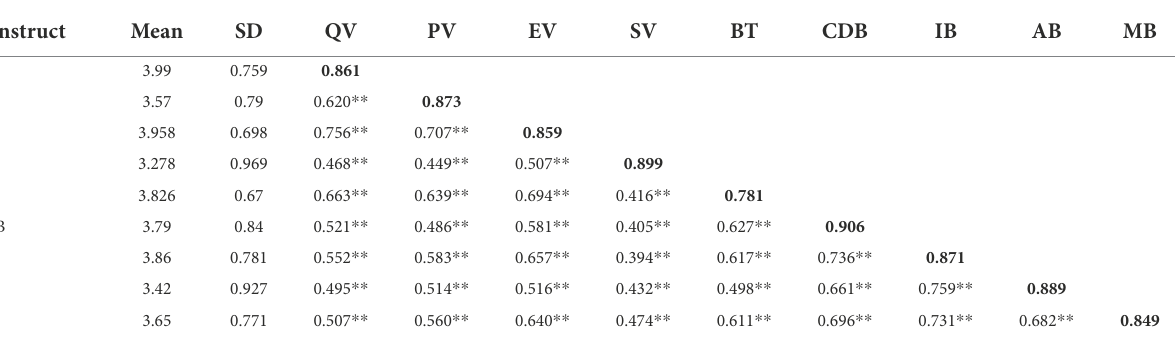
TABLE 2 Correlations of the constructs.